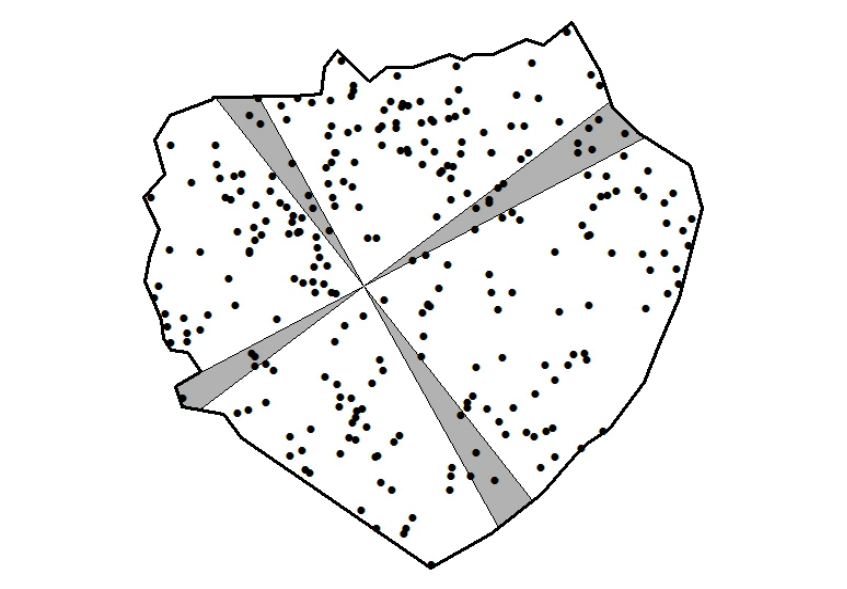
Figure 2. A 10% systematic sample of objects in a polygon using four orthogonal 9° sectors. Objects (trees) shown as black dots. Based on